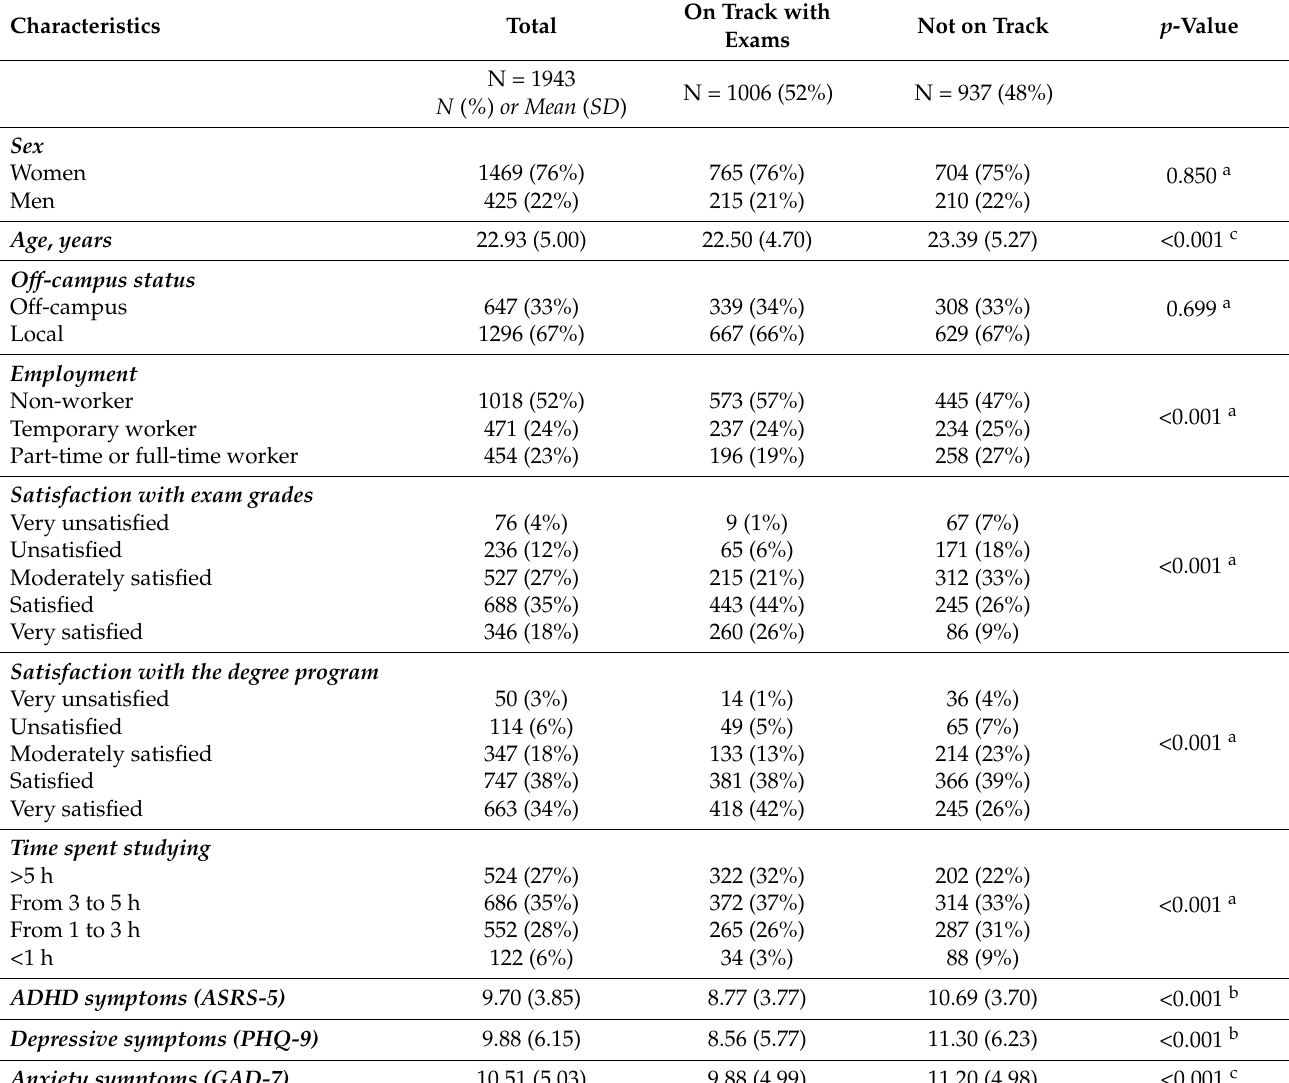
Table 1. Sociodemographic and clinical characteristics distribution according to academic perfor- mance (being on track vs. not being on track with